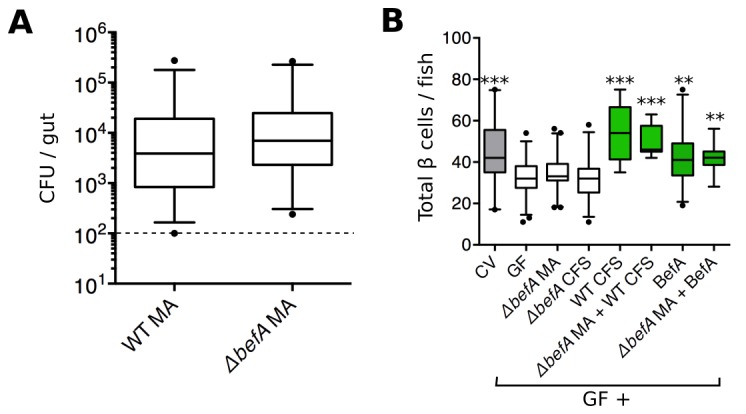
BefA is required for Aeromonas to induce GF β cell expansion.(A) Quantification of the colony forming units (CFUs) per gut in GF fish mono-associated (MA) with either wild type (WT) or mutant (△befA) A. veronii strains for 48 hr. Dashed line denotes the limit of detection (B) Total β cells in GF fish that have been mono-associated with △befA, treated with CFS from either WT or △befA, treated with purified BefA, or have been inoculated with a combination of these. **p<0.01, ***p<0.001: Denotes treatment that is significantly different than GF by Tukey analysis.DOI:
http://dx.doi.org/10.7554/eLife.20145.01310.7554/eLife.20145.014Figure 4—source data 1.Quantifications and statistical analysis of larval β cells corresponding to Figure 4B.Exact values of N, mean, median, SD, and SEM are reported in the source data file and are highlighted in yellow, magenta, blue, green, and cyan, respectively.